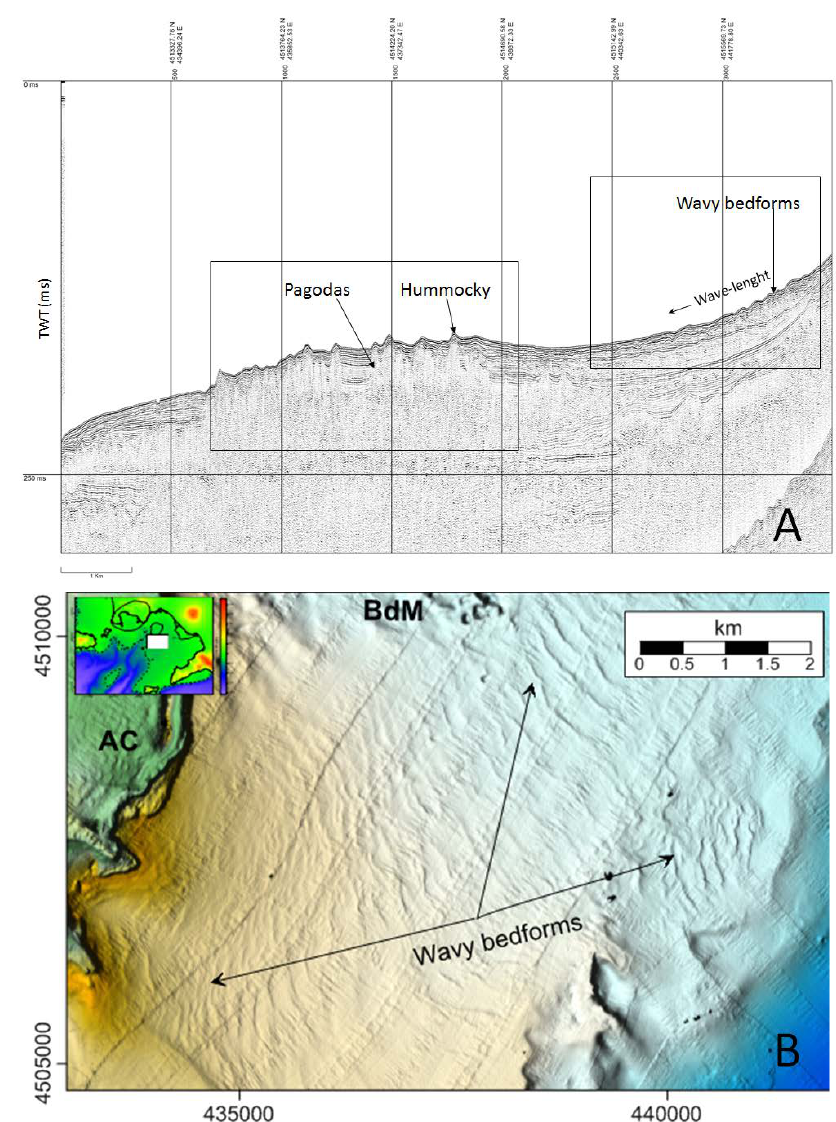
Figure 5. ( A ) S2 Sparker mono-channel profile showing the sediment wave sector of Somma-Vesuvius seaward prolongation and rising pagodas with hummocky morphology at the seafloor of Banco della Montagna (BdM). The navigation line is in Figure 1. ( B ) Wavy bedforms in the deeper sectors of the shelf. The positioning frame is the white rectangle on the upper-left corner. BdM: Banco della Montagna; AC: the Ammontatura Channel.